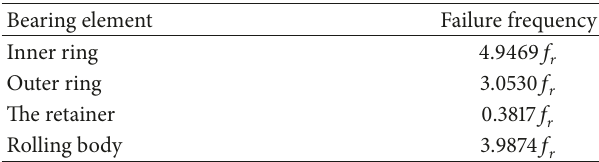
Table 2: Rolling bearing fault feature frequency ( 𝑓 𝑟 = 29.95